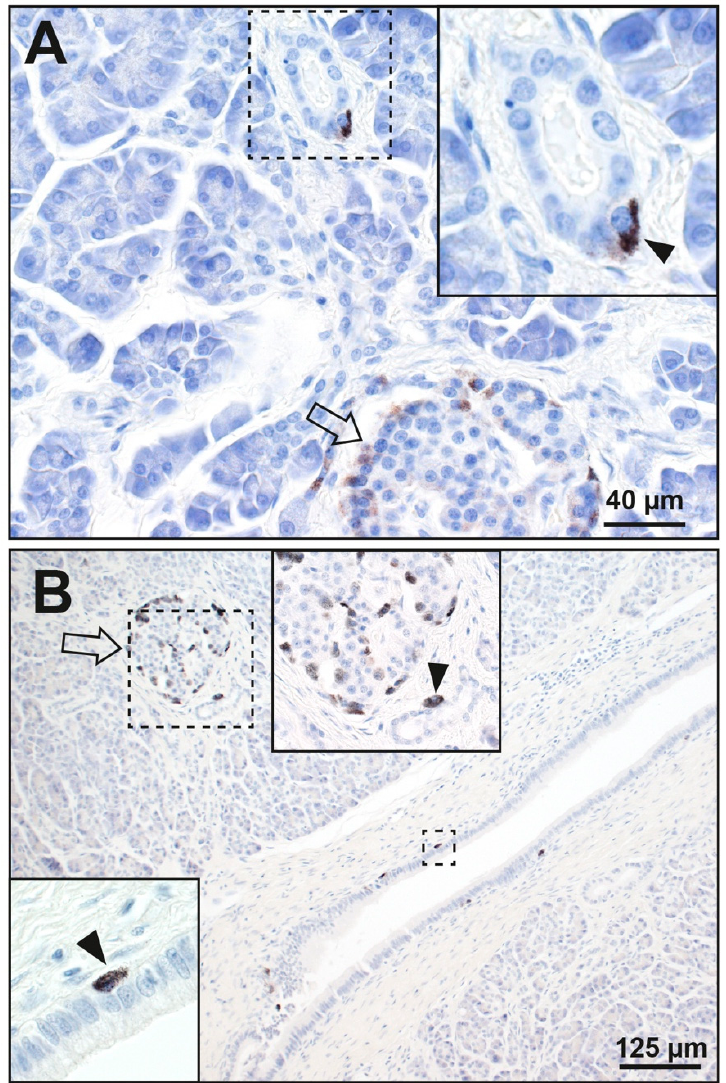
Figure 4. Mercury in pancreatic periductal cells. ( A ) The cytoplasm of one periductal cell abutting the epithelium of a small duct contains black mercury grains (inset, arrowhead). Some peripheral cells (arrow) of a nearby islet contain faintly-stained mercury. ( B ) Mercury is seen in scattered periductal cells adjacent to the epithelial cells of a large pancreatic duct (e.g., in the small dashed rectangle and lower left inset, arrowhead). Mercury is also seen in one cell (upper central inset, arrowhead) abutting a small duct. This is adjacent to an islet (arrow) which has peripheral and internal cells containing mercury. Autometallography/hematoxylin.